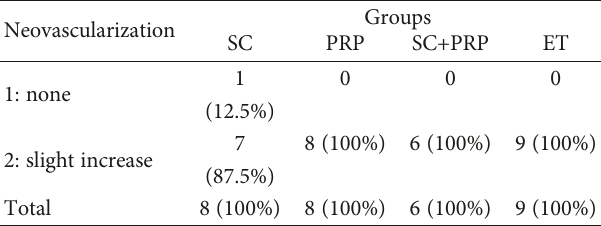
Figure 4: A histogram showing the histological scores in each group. 1 = SC ; 2 = PRP ; 3 = SC +PRP; 4 = ET . SC: stem cell; PRP: platelet-rich plasma; ET: eccentric training. Table 3: Analysis of neovascularization.